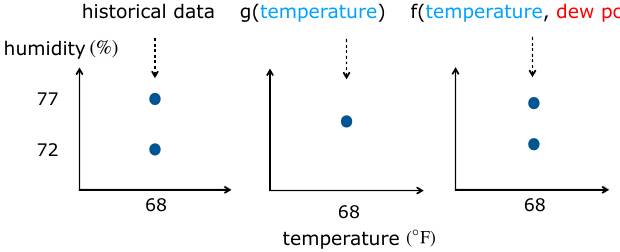
Figure 3. Illustration of the intuition behind